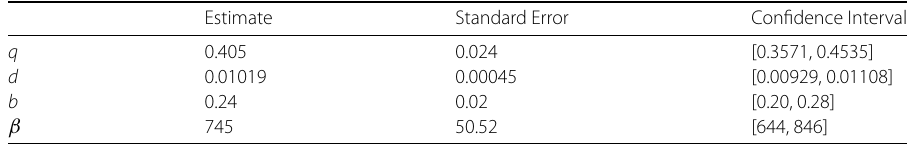
Table 1 Results of the parameter fitting